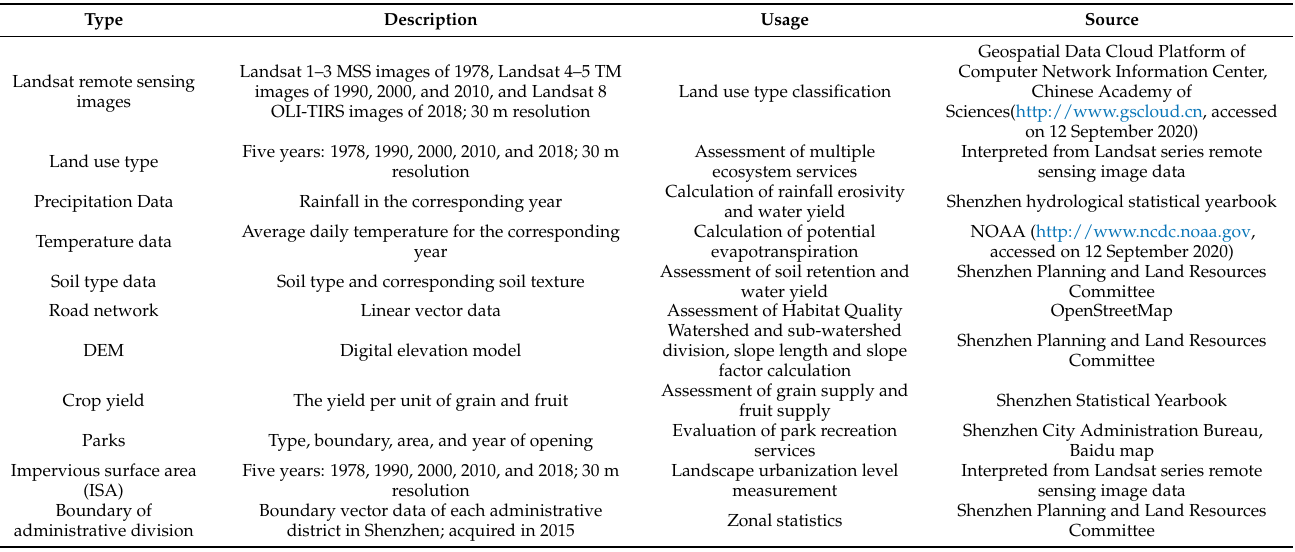
Table 1. Data sources and description.